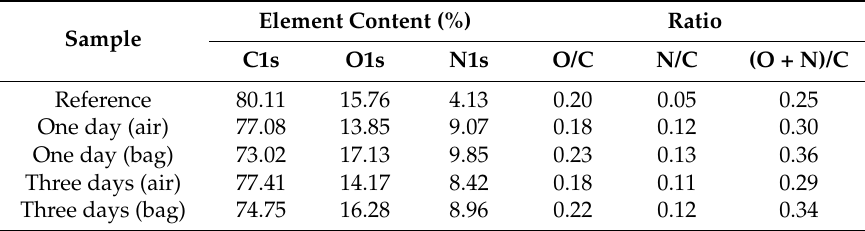
Table 4. Relative chemical compositions and atomic ratios with storage time and environment varying.